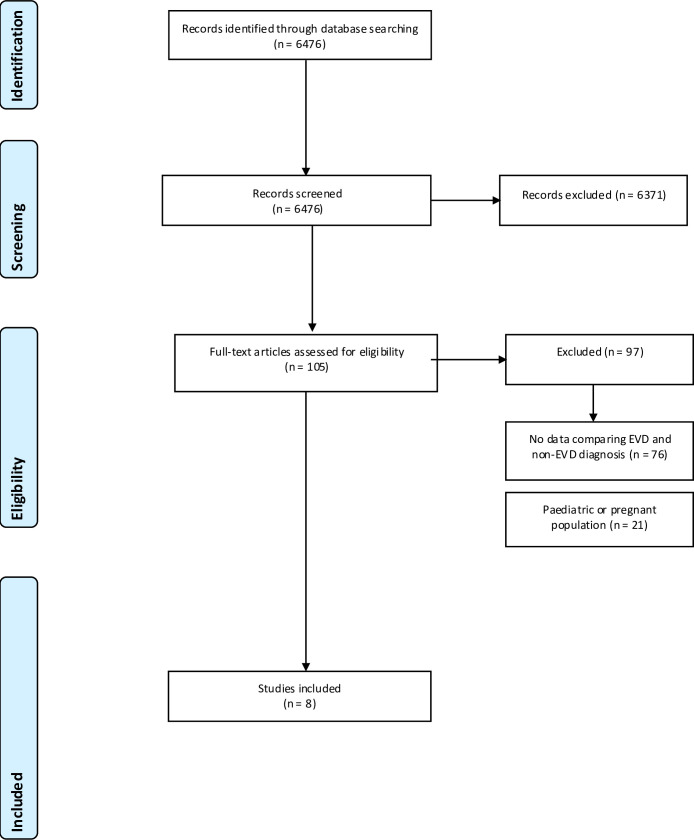
PRISMA flow diagram.